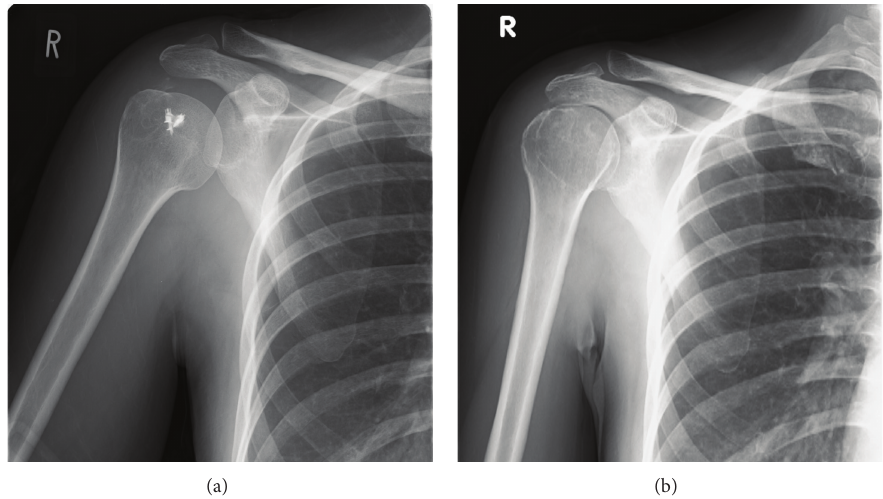
Figure 2: Plain radiograph (anteroposterior view). (a) Before the second surgery. (b) After the second